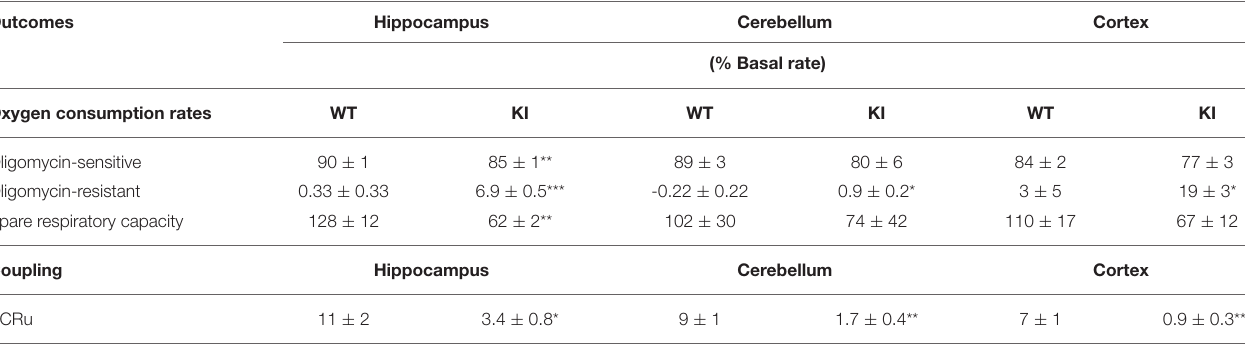
TABLE 2 | Mitochondrial coupling and respiratory capacity in intact, isolated neurons from WT and KI mice at PND0.